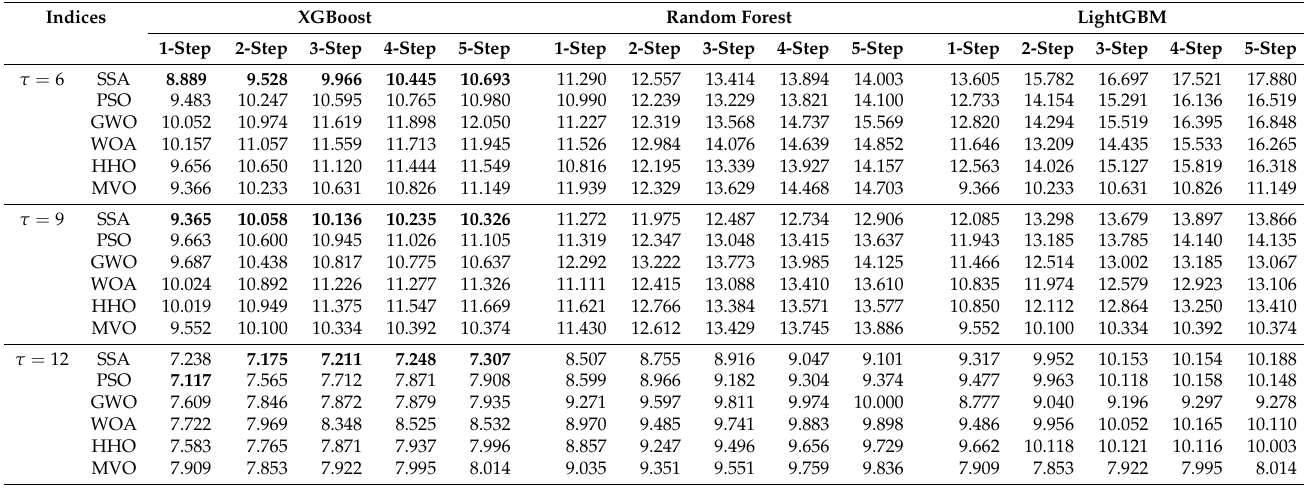
Table 6. MAPEs of multi-step ahead forecasting of the NGC of